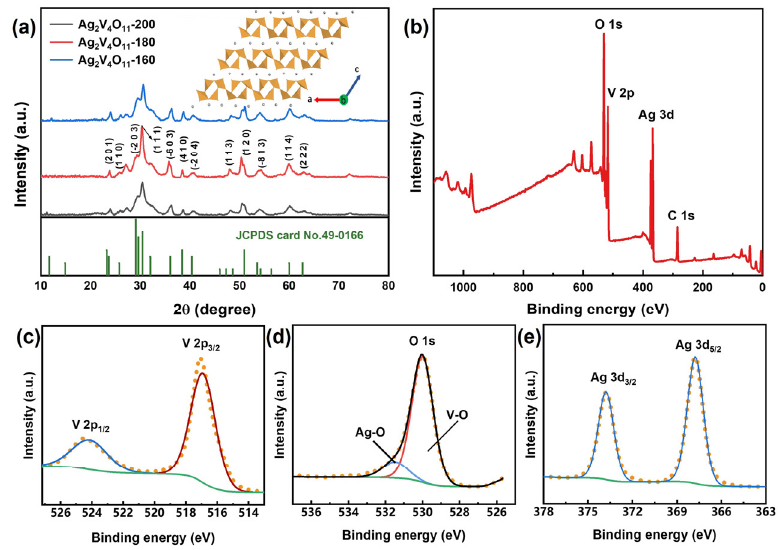
Figure 1. XRD patterns ( a ), XPS spectra ( b ), V 2p spectrum ( c ), O 1s spectrum ( d ) and Ag 3d spectrum ( e ) of Ag 2 V 4 O 11 .